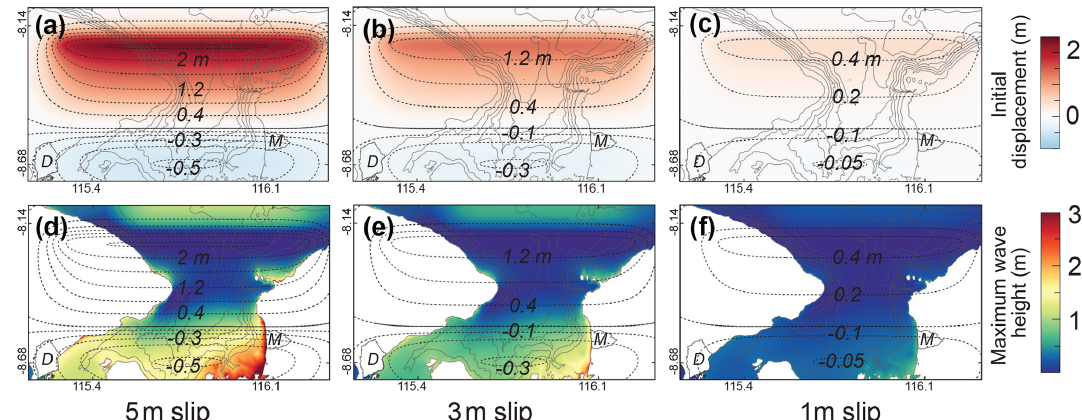
Figure 7. Initial surface deformation and maximum wave heights in 1h generated by different slip amounts on the full 45km wide fault ramp (model A). (a–c) The coseismic deformation generated by (a) 5m, (b) 3m, and (c) 1m fault slip events results in uplift in the northern half of the islands and subsidence in the south. (d–f) Maximum sea surface displacements for (d) 5m, (e) 3m, and (f) 1m fault slip events. Maps are adjusted to show wave heights relative to the post-earthquake land surface rather than initial sea level by subtracting the coseismic displacement (dashed contour lines). The west coast of Lombok is hit by higher tsunami waves than the southeastern coast of Bali. Polygons on land – cities of Denpasar, Bali, and Mataram, Lombok. D denotes Denpasar; M denotes Mataram.